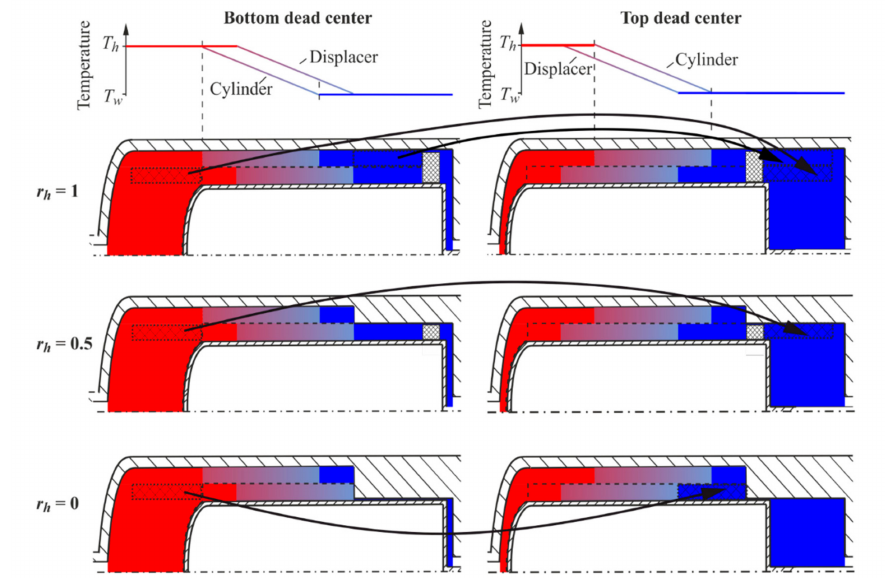
Figure 4. Temperature distribution in the cylinder system in dependency on the gap width ratio and the displacer